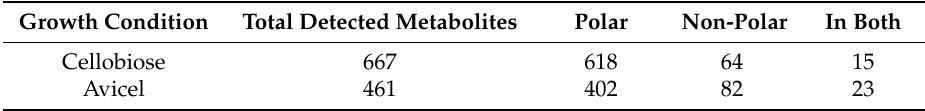
Table 1. Summary of compounds identified in the wild type strain of Thermobifida fusca when grown on cellobiose and Avicel media growth conditions.